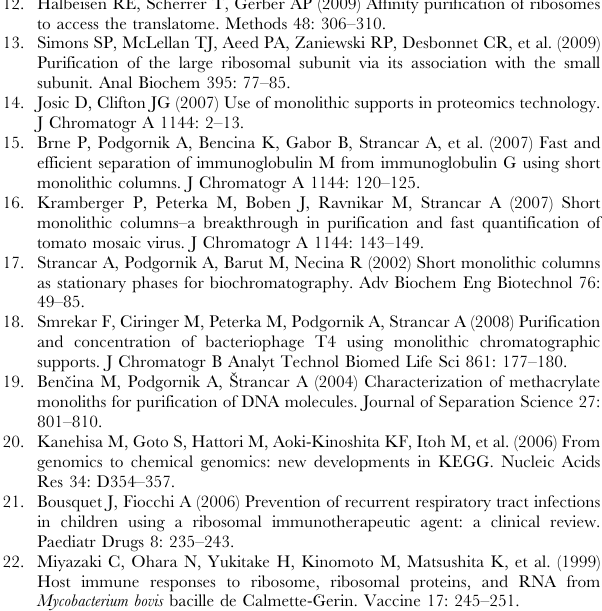
for FPLC purified/sucrose purified peptides for 30S ( B ) and 50S Figure S4 Monolith-FPLC purified ribosomes show biological activity. ( A ) Ribosomes from actively growing E. coli were isolated by monolith FPLC and used for coupled transcrip- tion-translation (T-T) assay expressing firefly luciferase. ‘‘FPLC + ’’ ribosomes isolated by FPLC and concentrated by ultracentrifuga- tion, ‘‘FPLC’’ ribosomes isolated by chromatography, ‘‘No DNA’’ unaltered kit without template, ‘‘PBS’’ dilution buffer alone. ( B ) Binding of [ 3 H]-erythromycin by FPLC purified Msm wild type ribosomes that were concentrated using centrifuge filtration. Control experiments were performed in the absence of ribosomes (to assess the efficiency of the wash step to remove unbound antibiotic from filters). T-T: histograms represent the average of 10 readings; error bars correspond to the standard deviation (N =10).